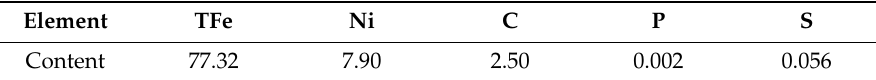
Table 4. The chemical compositions of the magnetic product (wt %).